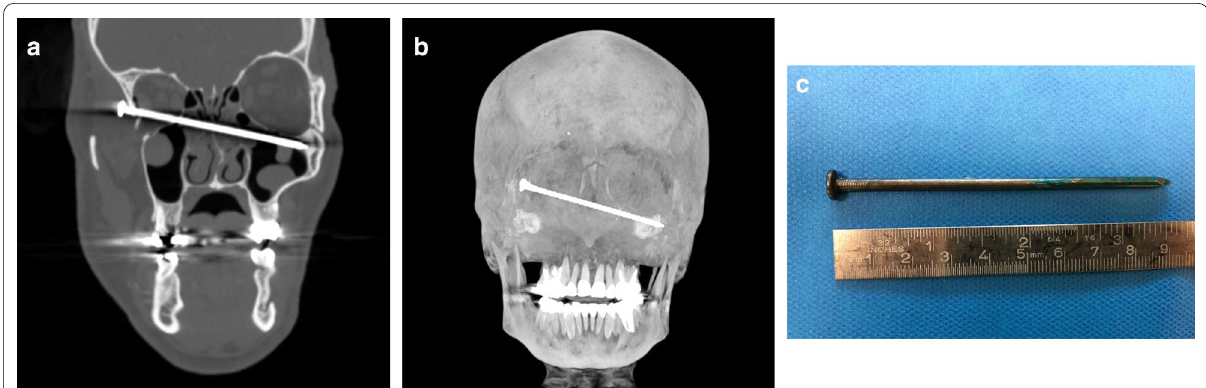
Fig. 8 Nail gun. Para‑coronal CT image ( a ) and a 3‑dimensional maximum intensity projection ( b ) showing a hyperdense straight foreign object entering the right lateral wall of the orbit, penetrating the left ethmoidal cells and the left maxillary sinus. A photograph of a metal nail after removal from the midface ( c )